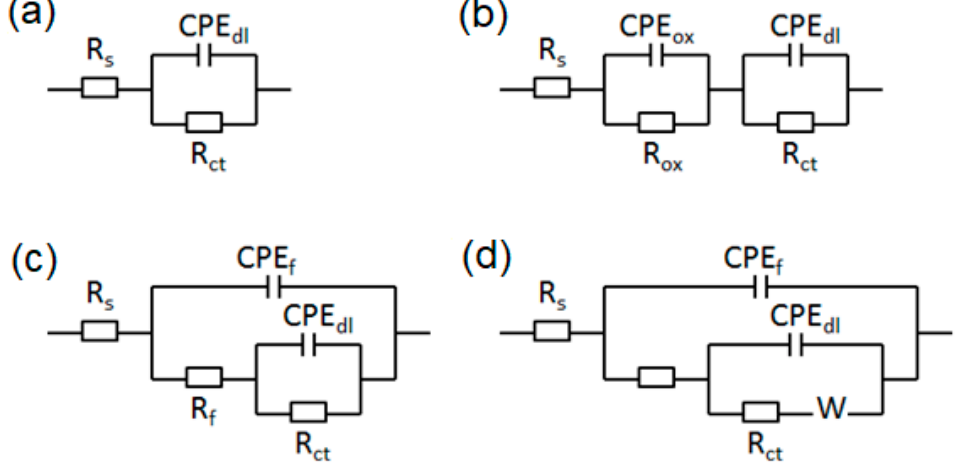
Figure 4. Di ff erent equivalent circuits most often used to fit EIS data of SAC alloy corrosion: ( a ) oxide layer not influence the impedance response; ( b ) surface is covered with a barrier oxide layer; ( c ) surface is covered with a porous oxide; ( d ) the surface is covered with a porous oxide and the charge transfer of metal dissolution is di ff usion controlled. R s : solution resistance, CPE dl : Constant Phase Element ( CPE ) of double layer, R ct : charge transfer resistance of metal dissolution, CPE ox : CPE of passive oxide layer, R ox : resistance of passive oxide layer, CPE f : CPE of porous surface film, R f : resistance of electrolyte in the pores of surface film, W : Wartburg element of di ff usion.